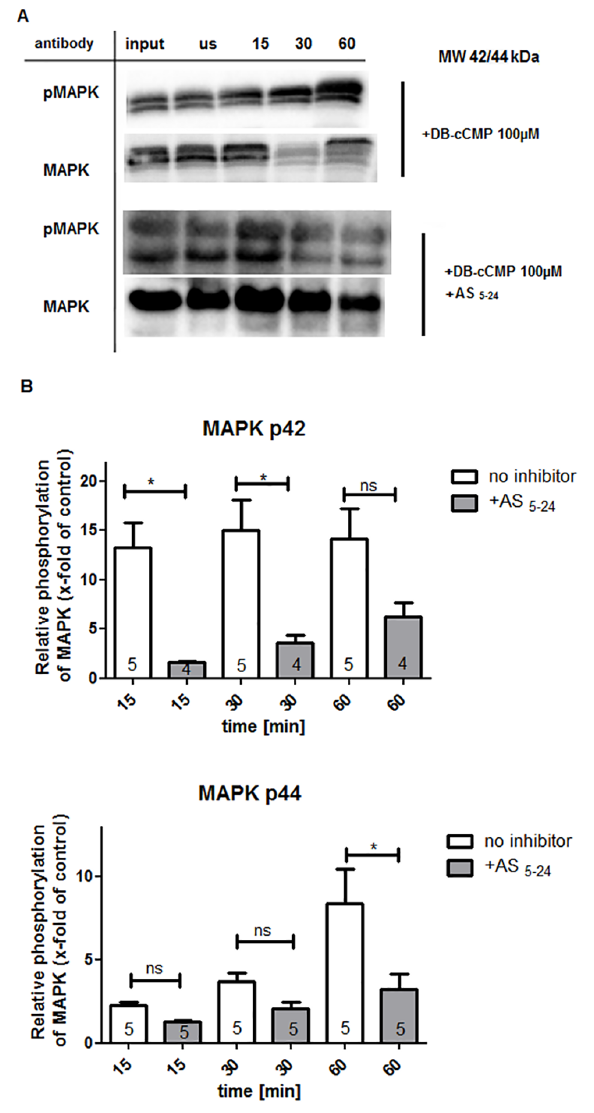
Fig 7. Activation of MAPK by cCMP (A) Jejunum tissue lysate (WT) or lung tissue lysate (WT) (S5 Fig) was treated with 100 μ M DB-cCMP for the indicated times (15/30/60 min). A protein kinase A inhibitor (AS μ M) was added or omitted (as described in the Material and Methods). As control, 5-24 cAK inhibitor, 10 untreated (1 μ g/ μ L, indicated with input) and unstimulated tissue lysate (2.5 μ g/ μ L, indicated with ‘ us ’ ) was used. Control samples ( ‘ us ’ ) were treated like DB-cCMP stimulated samples but, instead of DB-cCMP, water was added. The phosphorylation of MAPK was detected by immunoblotting using a phospho-p44/42 MAPK antibody (pMAPK). Total MAPK was measured by stripping the membrane and retreating with the respective antibodies. (B) Densitometry analysis of 4 – 5 independent experiments (numbers in columns) was performed to quantitate p44/42 MAPK levels. Data were expressed as x-fold MAPK phosphorylation relative to untreated control samples. Error bars show mean ± SEM and asterisks indicate statistically significant differences, ns: not statistically